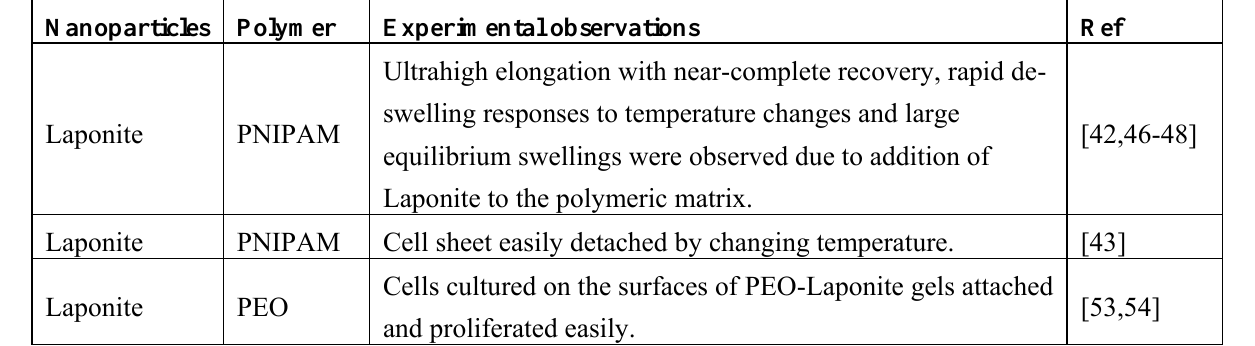
Table 2. Polymer-Laponite nanocomposite hydrogels with biomedical potential.